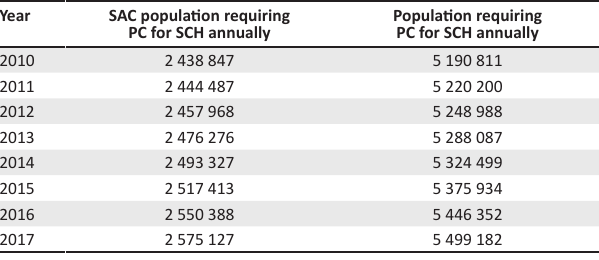
Source : World Health Organization. Schistosomiasis: Population requiring preventive chemotherapy and number of people treated in 2010. Releve Epidemiol Hebdomadaire. 2012;87(4):37–44. PC, preventive chemotherapy; SAC, school age children; SCH, schistosomiasis. Note: SAC population requiring PC for SCH annually: estimated number of school age children requiring preventive chemotherapy for schistosomiasis annually according to the recommended strategy. Population requiring PC for SCH annually: estimated number of